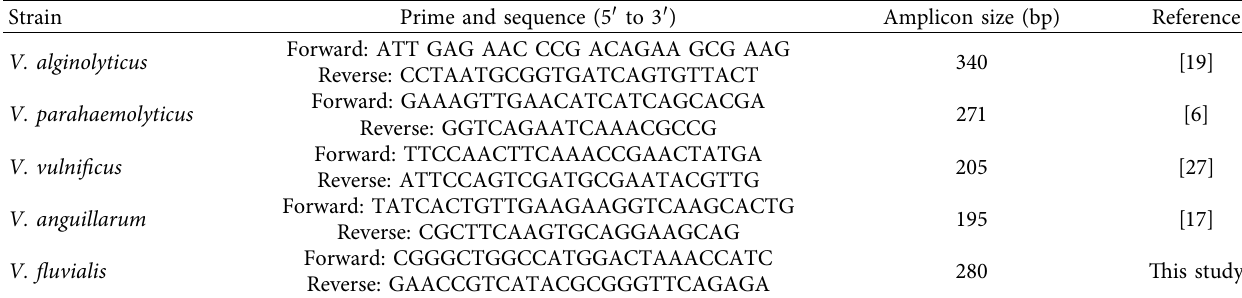
Table 3: Oligonucleotide primer used in this